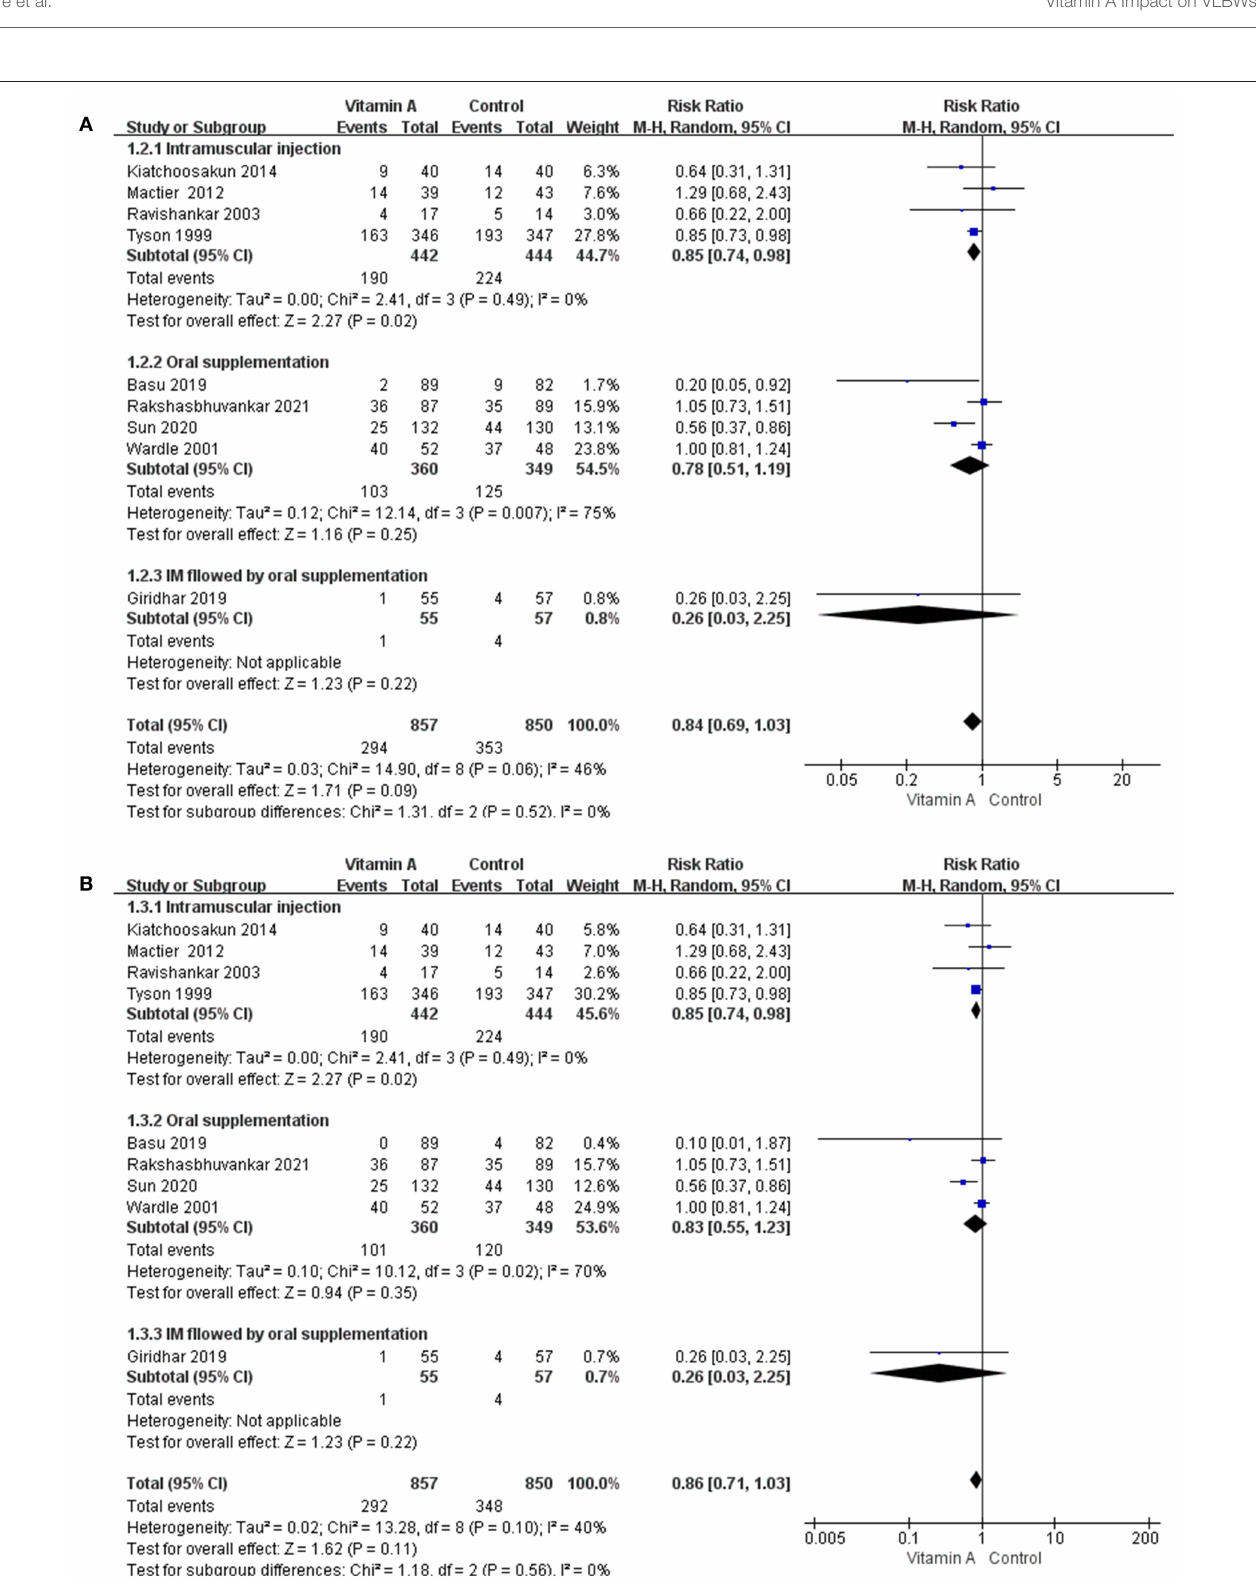
FIGURE 6 | The subgroup analyses based on the methods of vitamin A supplementation. (A) The forest plot for the incidences of BPD at 36 weeks’ PMA. (B) The forest plot for the incidences of moderate to severe BPD.